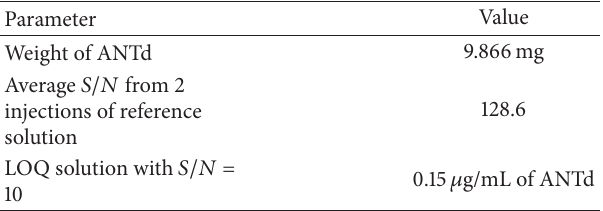
Table 6: Results: practical verification of LOD.